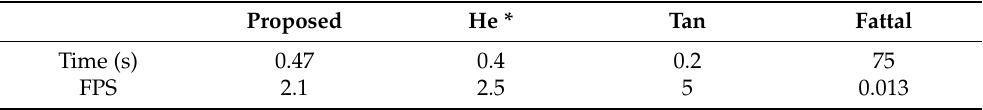
Table 7. Time consumption of each